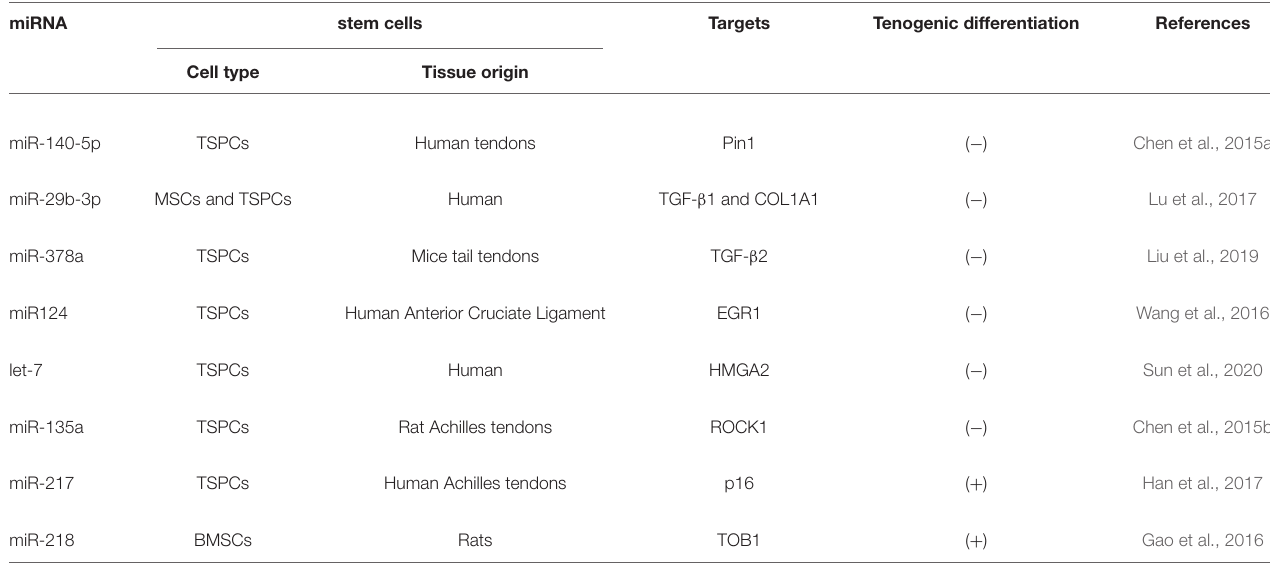
TABLE 2 | Summary of miRNAs in tenogenic differentiation ( + ).